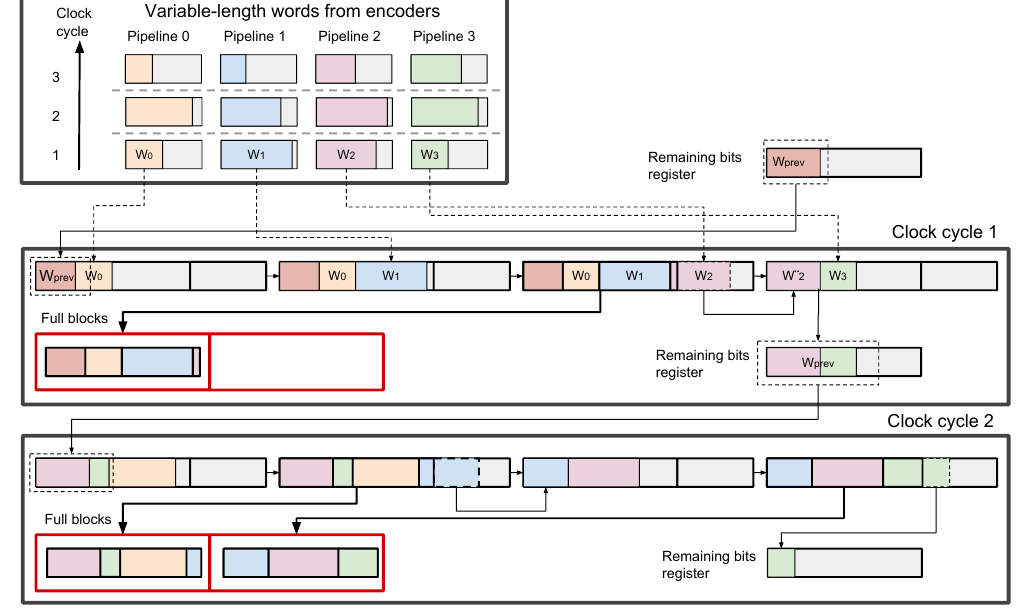
Figure 9. Operation of the variable length word